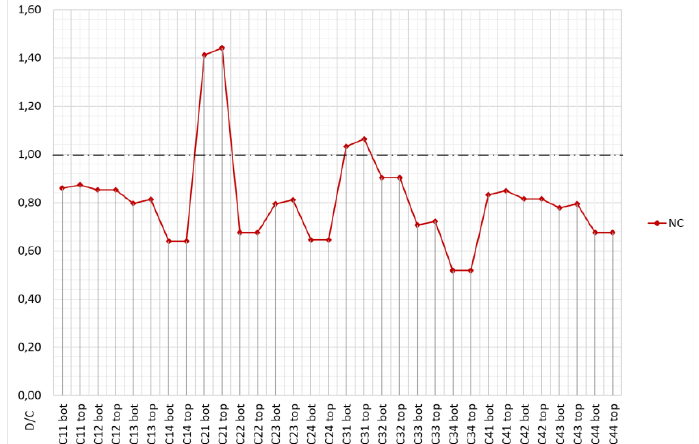
Figure 11. DCM: NC shear force 𝐷 𝐶⁄ ratios on columns (pushover analysis).